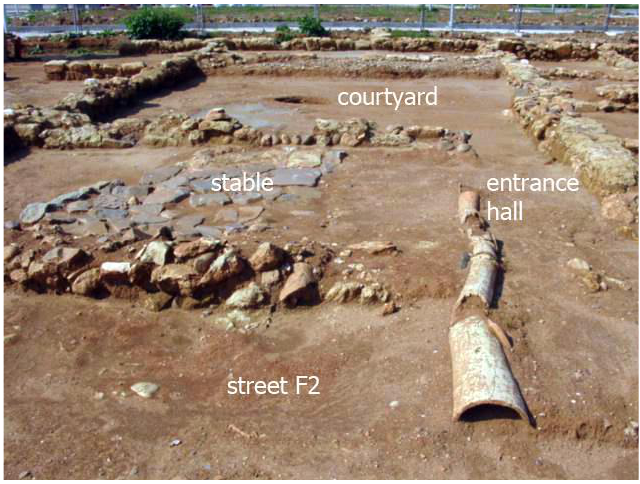
Figure 16. House 51. In the northern bay, the alcove and the living room can be distinguished.